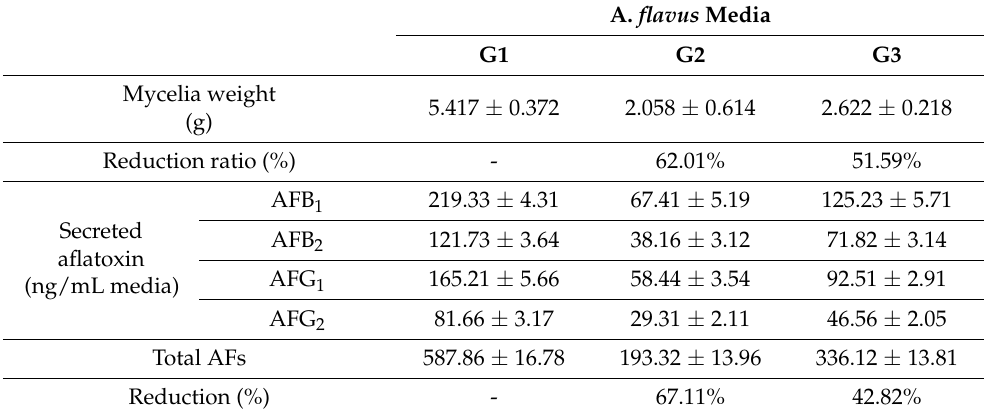
Table 2. Antiaflatoxigenic properties of applied extracts (water and aromatic) in simulated